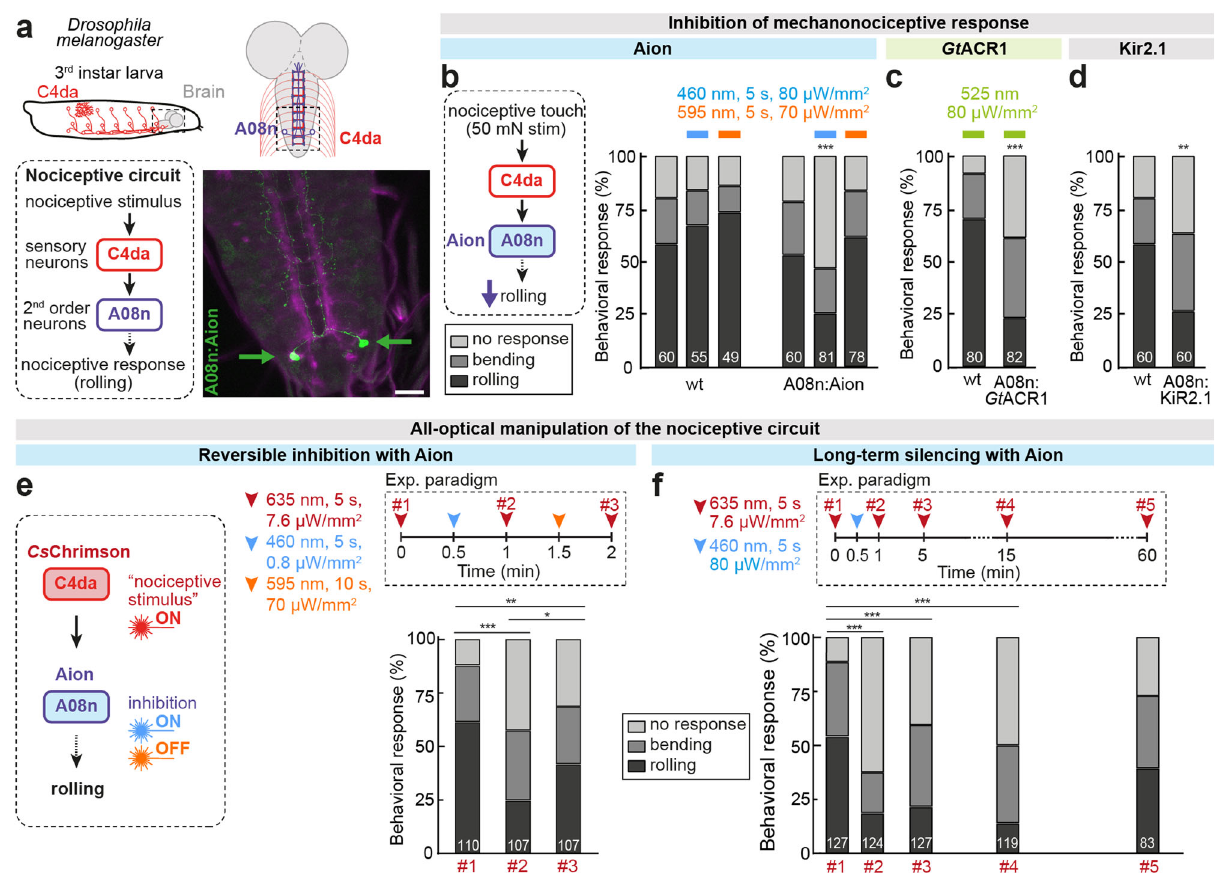
Fig. 6 Aion enables inhibition of nociceptive circuit function in Drosophila melanogaster larvae over extended time periods. a Schematic model of nociceptive sensory neurons (C4da) and connected downstream neurons (A08n) in Drosophila larvae. The example image shows Aion expression in A08n neurons (green, maximum intensity projection of confocal image stack). Fas3 staining (magenta) was used as a sensory axon marker for orientation. Arrows indicate cell bodies of A08n neurons. Scale bar: 20 µ m. b Nociceptive touch responses were strongly reduced after blue light in animals expressing Aion in A08n neurons, but not in controls (wt). The responses could be fully recovered after orange light exposure. c Larvae expressing Gt ACR1 in A08n neurons showed robustly reduced nociceptive responses under constant green light exposure. d Constitutive silencing by expression of Kir2.1 in A08n neurons leads to similarly strong inhibition of larval nociception as with Aion. For b – d the behavioral response to a 50 mN mechanical stimulus is shown. e All-optical paradigm for inhibition of A08n neurons with Aion and activation of C4da neurons with Cs Chrimson. Repeated induction of nociceptive behavior with red light was strongly inhibited after blue light-induced Aion activation and largely reversed by orange light. f Activation of Aion expressed in A08n neurons with a single blue light pulse (5 s) resulted in reduction of nociceptive responses for at least 15 min and partially recovered only after 60 min. For e , f behavioral responses to Cs Chrimson activation in C4da neurons at the indicated time points are shown. Χ 2 -test, n of animals are indicated by white numbers in b – f . For clarity, only signi fi cant differences are indicated. * p < 0.05, ** p < 0.01, *** p < 0.001 For further details on statistics see Supplementary Data